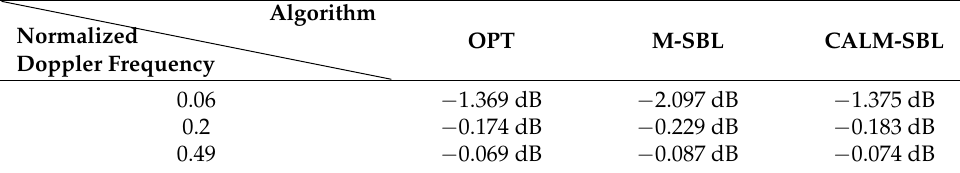
Table 3. SINR loss comparison of Figure 6.